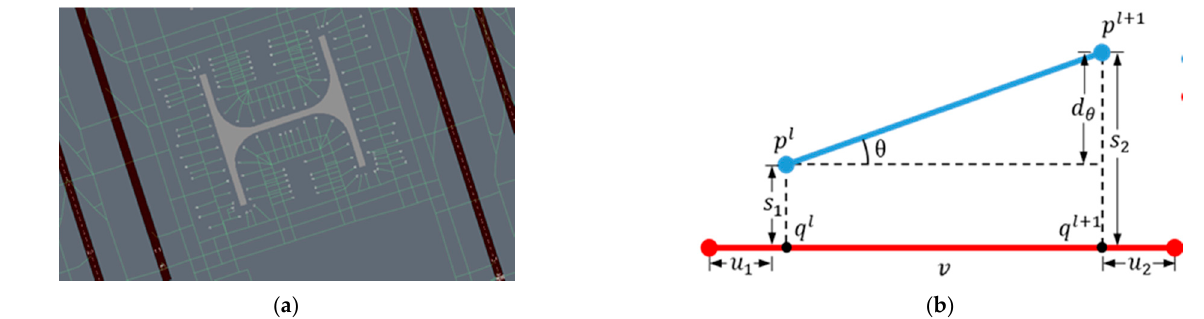
Figure 3. Taxiing path inside the apron area, ( a ) apron topology; ( b ) scheme of relative position of two line segments.